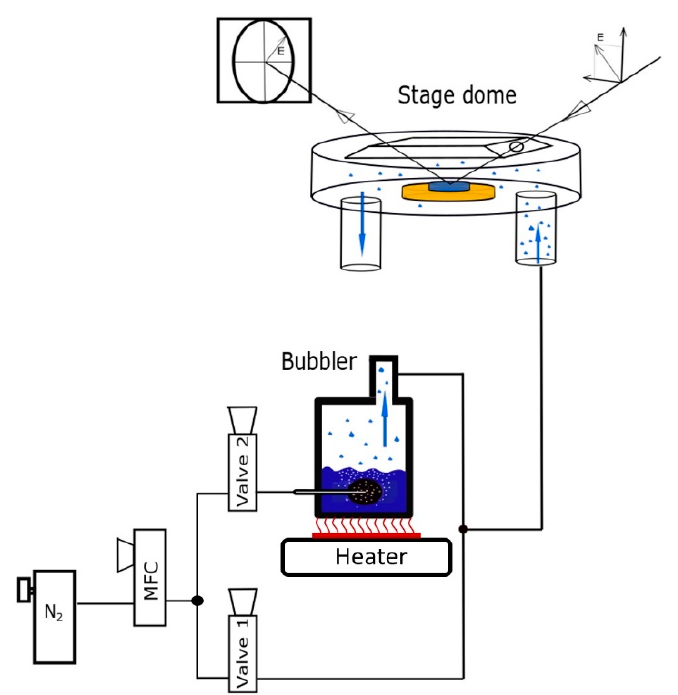
Figure 5. Experimental setup for ellipsometric porosimetry (EP) measurements: The opening ratio between valve 1 and valve 2 sets the relative humidity in the sample stage dome (sample in blue in the cartoon). Additional heating increases the RH beyond 85%. The refractive index of the sample inside the dome is measured via ellipsometry. A RH-sensor measures the humidity inside the dome. The water droplet produced in the bubbler and reaching the stage dome are represented as blue dots.